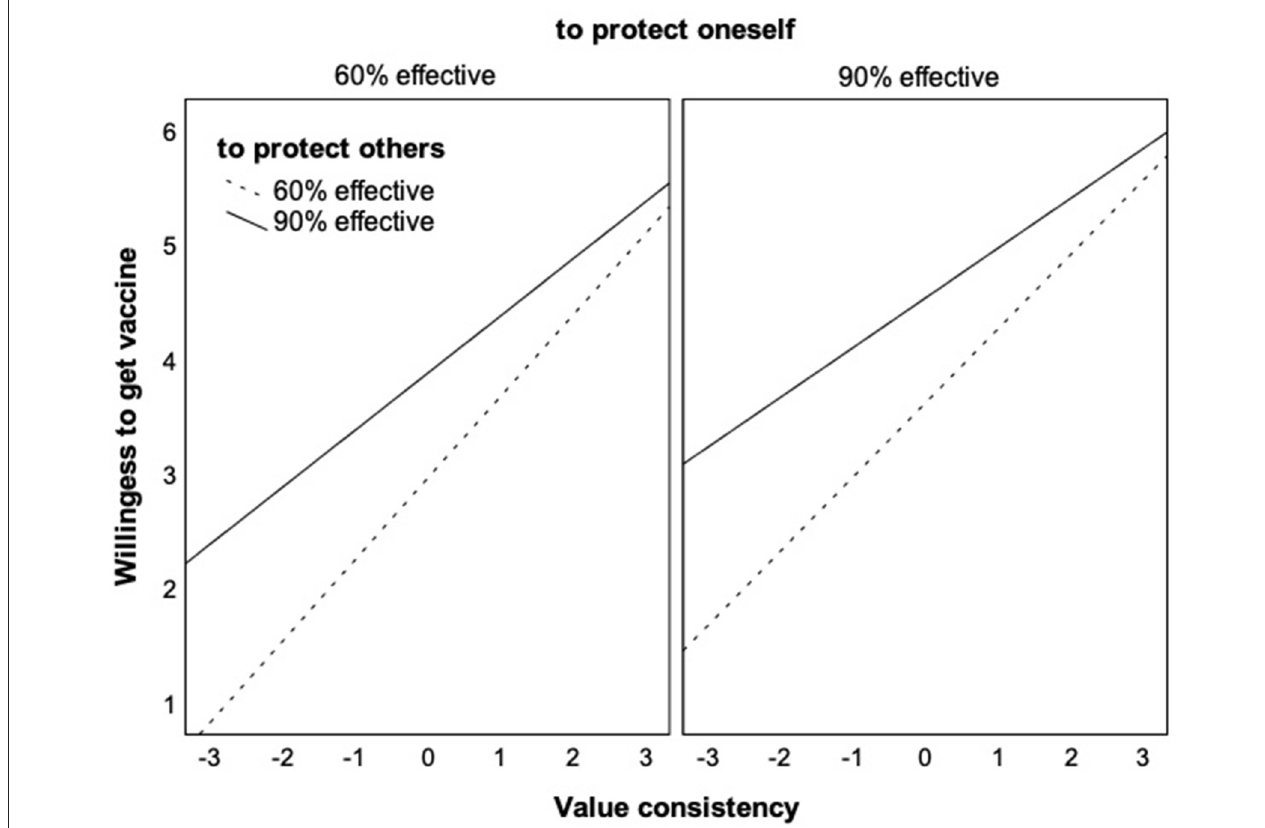
FIGURE 5 | Interaction effects of value consistency with the efficacy to protect the self or others on the willingness to get vaccinated. The figure shows the unique effects of each interaction in the combined model (see Supplementary Table 3.4 for conditional